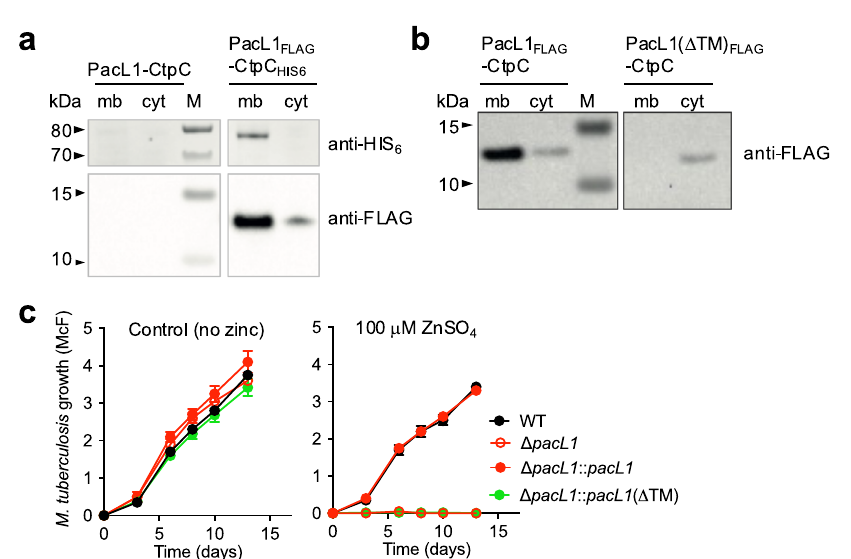
Fig. 2 | PacL1 is a membrane-associated protein. a Western blotting analysis of cytosolic (cyt) and membrane (mb) extracts of M. smegmatis Δ 2 expressing recombinantnative PacL1and CtpC(leftpanel),or FLAG- andHIS 6 -taggedPacL1 and CtpC, respectively (right panel). The top and bottom membranes were detected with anti-HIS 6 and anti-FLAG, respectively. M molecular size marker. Data are representative of 2 independent experiments. b Western blotting analysis of cytosolic (cyt) and membrane (mb) extracts of M. smegmatis Δ 2 expressing recombinant CtpC with FLAG-tagged PacL1 (left panel), or FLAG- tagged PacL1 deleted of its transmembrane domain ( Δ TM, right panel).